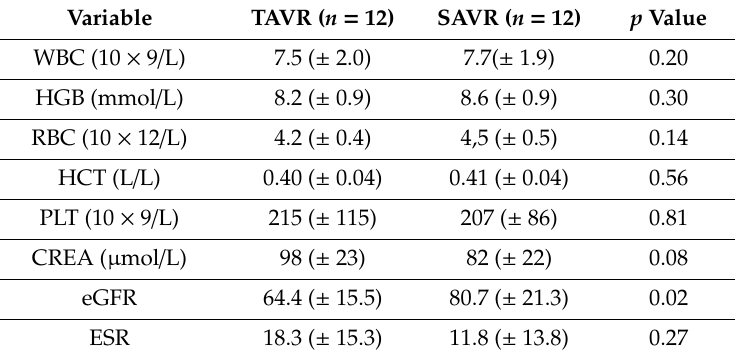
Table 2. Baseline laboratory